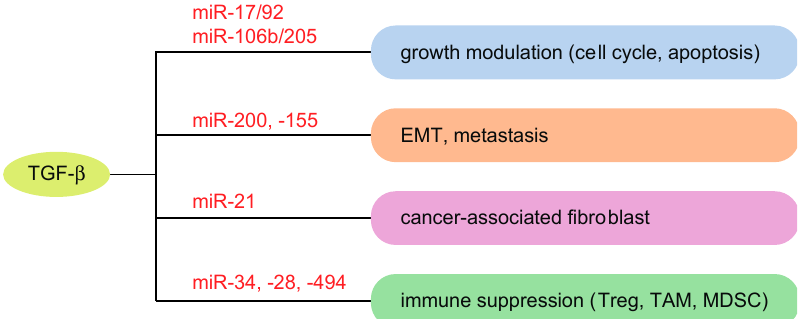
Figure 3. Roles of TGF- β -related miRNAs in cancer progression. Examples of miRNAs modulating TGF- β -associated cancer properties are shown. Treg: regulatory T cells; TAM: tumor-associated macrophages; MDSC: myeloid-derived suppressor cells.